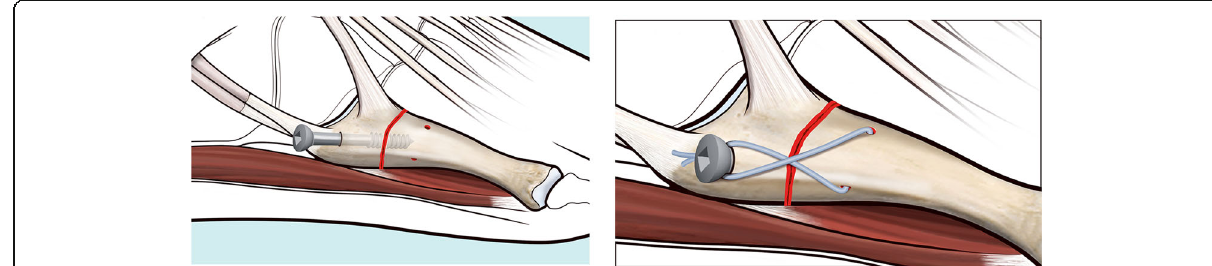
Fig. 7 Diagram of screw position, of cerclage hole and final result. Note that the screw entry point in the figure has been deliberately drawn slightly lateral to aid